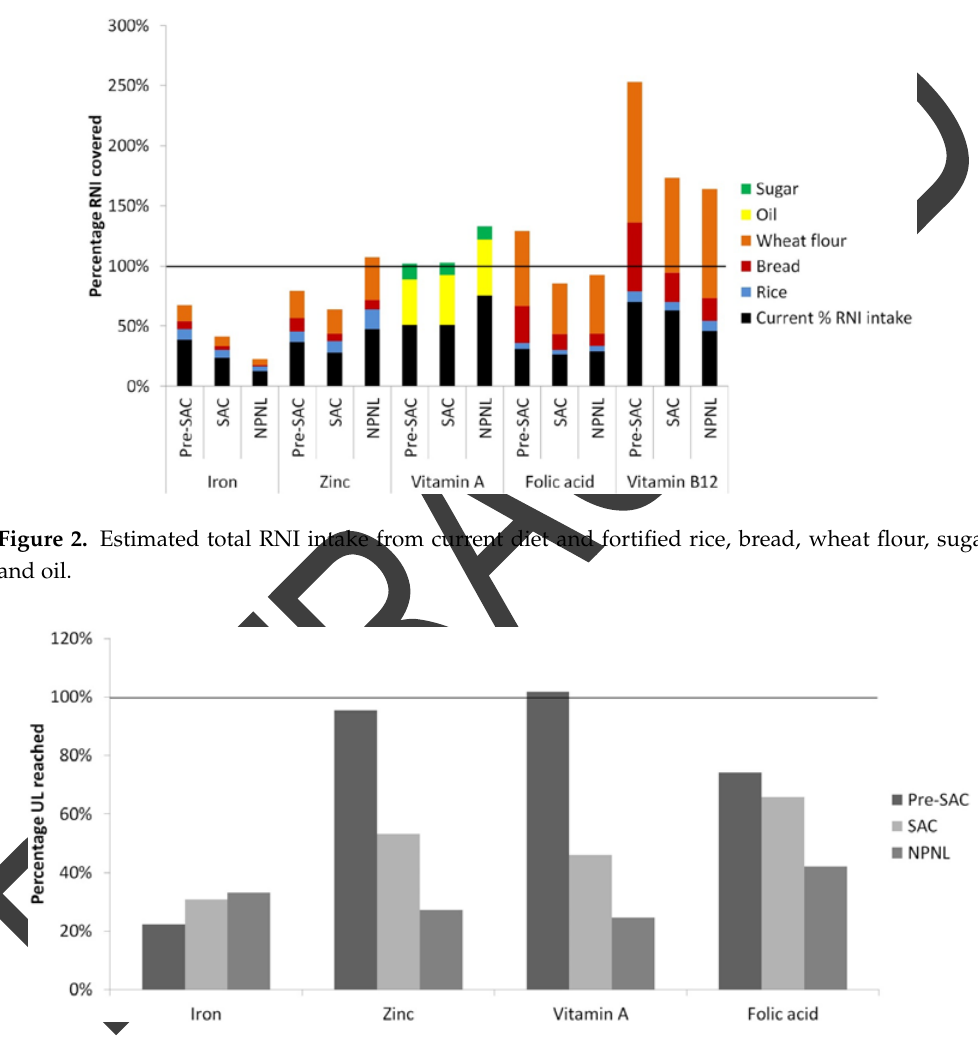
Figure 3. Estimated percentage of UL reached from multiple food fortification (based on the upper 95% consumption level and micronutrient intake). Table 5. Estimated daily contribution from fortified rice, bread, and wheat flour (using mean amounts consumed per day by each population group, and proposed fortification levels).